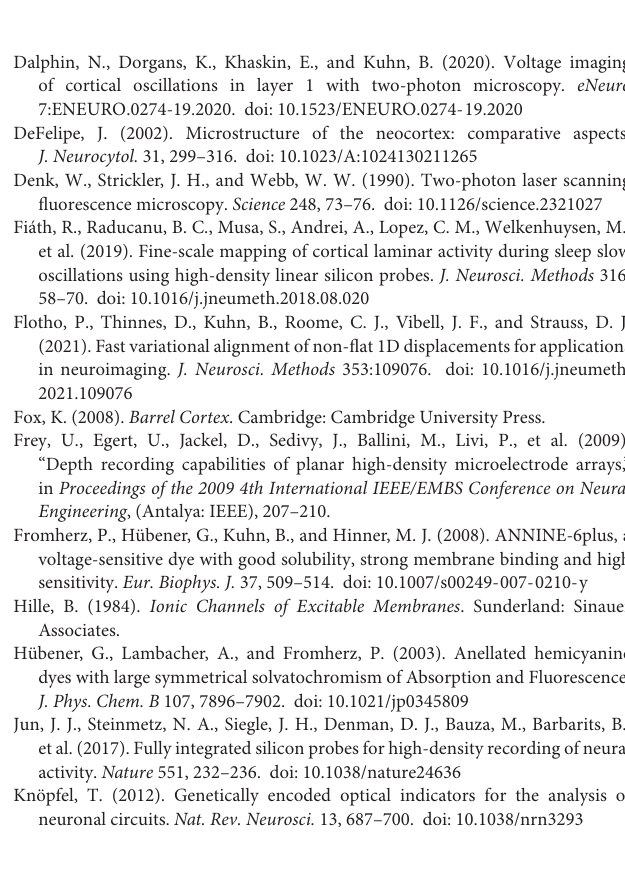
Supplementary Figure 1 | Average calcium responses in barrel cortex in response to air puff stimulation in anesthetized (A) and awake but resting mice at three different cortical depths, separated in (B) positive and (C) negative signals. Responses are plotted as averages over: for anesthetized, 50 µ m: 70, 57, 54, 55 trials; 130 µ m: 58, 58, 52, 53 trials; 400 µ m: 62, 59, 50, 57 trials; for awake resting, 50 µ m: 59, 51, 50, 53 trials; 130 µ m: 64, 60, 45, 58 trials, 400 µ m: 62, 56, 48, 49 trials. Every color represents one mouse. The gray dashed line indicates the air puff onset. Supplementary Figure 2 | Average calcium responses in barrel cortex in response to air puff stimulation in awake mice during running at three different cortical depths, separated in (A) positive and (B) negative signals. Responses are plotted as averages over: 50 µ m: 5, 6, 9, 4 trials; 130 µ m: 0 (no running traces), 2, 6, 1 trials, 400 µ m: 3, 3, 13, 6 trials. Every color represents one mouse. The gray dashed line indicates the air puff onset. Supplementary Figure 3 | Zoom in on average LFP responses to vibrissa stimulation of Figure 2 . Supplementary Figure 4 | Zoom in on average LFP responses to whisker stimulation of Figures 3 – 5 . Supplementary Figure 5 | Representative 375 × 375 µ m 2 field of view for calcium imaging and calcium transients of few selected most responsive cells during the experimental conditions in response to air puff stimulation. (A) 50 µ m (layer I), (B) 130 µ m (layer II), (C) 400 µ m (layer